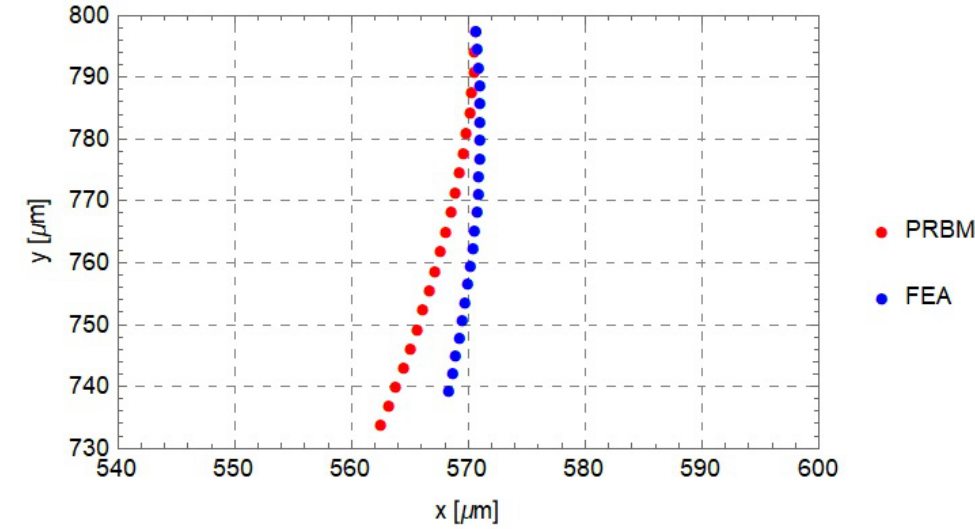
Figure 16. Tip displacements for the PRBM and for the corresponding compliant mechanism. Input displacements vary from ∆ u = − 1 µ m to ∆ u = − 20 µ m.